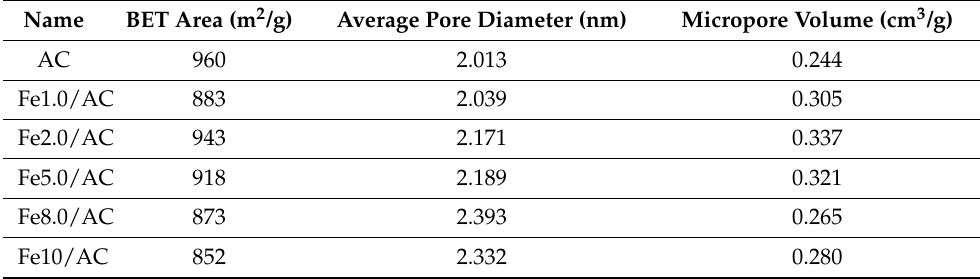
Table 1. Properties of AC and Fe 2 O 3 /AC